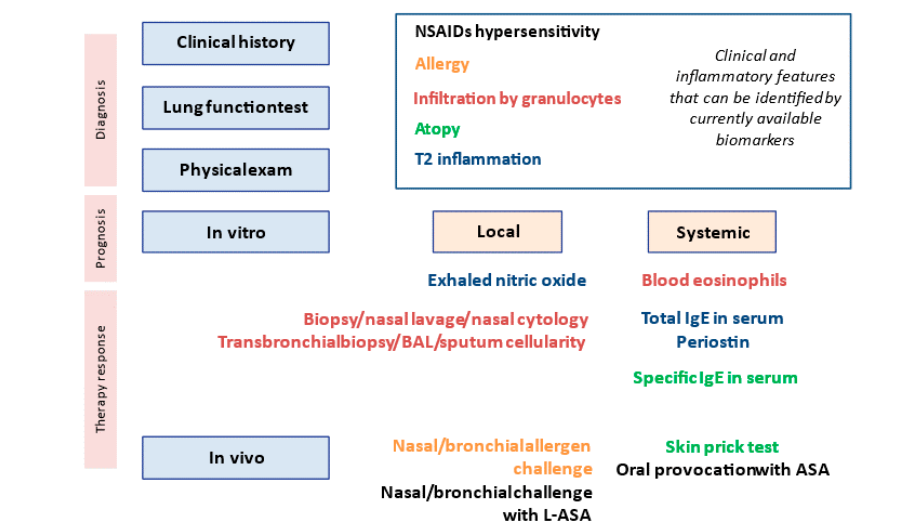
Figure 2. Immunopathological interpretation of biomarkers used for asthma phenotyping. ASA: acetylsalicylic acid; BAL: bronchoalveolar lavage; IgE: immunoglobulin E; L-ASA: lysine-acetylsalicylic acid; T2: type 2 inflammation. NSAID: non-steroidal anti-inflammatory drug.